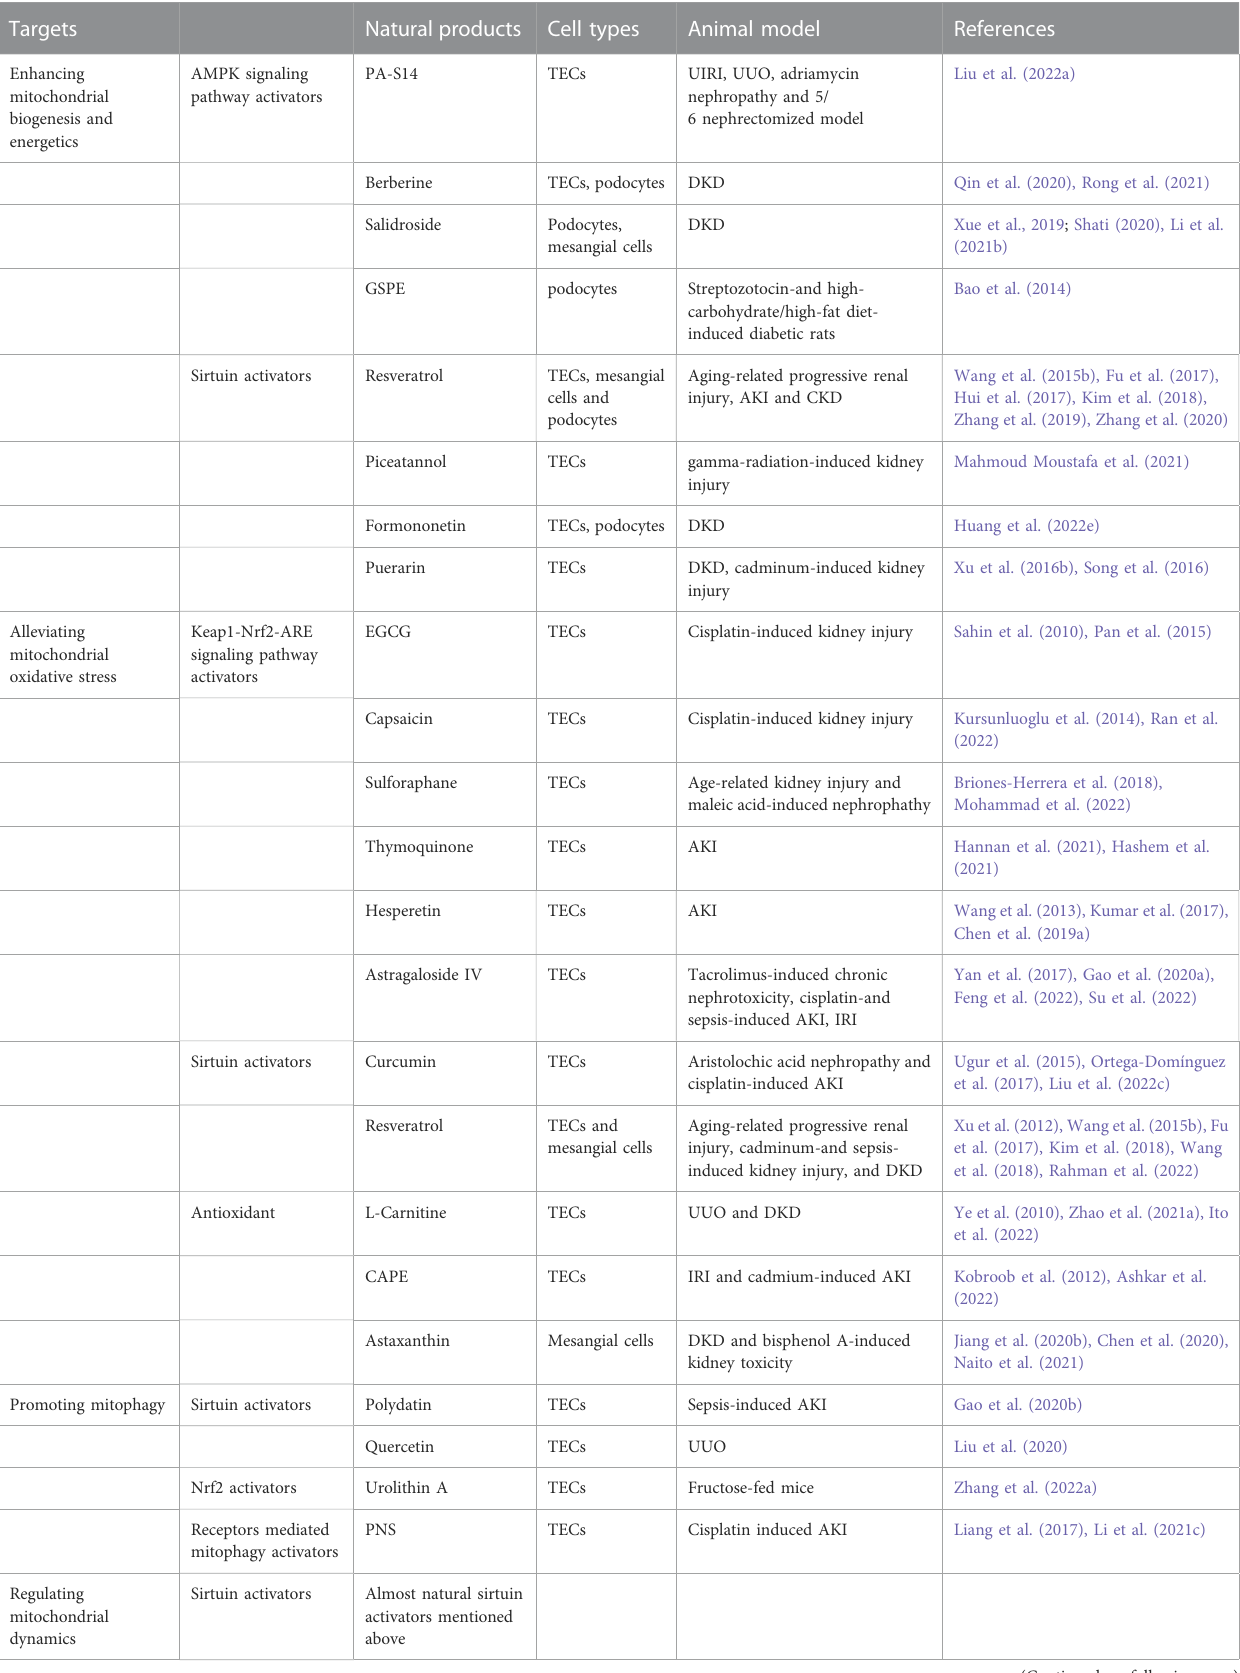
TABLE 1 Therapeutic mechanisms and targets of natural products targeting mitochondria in kidney